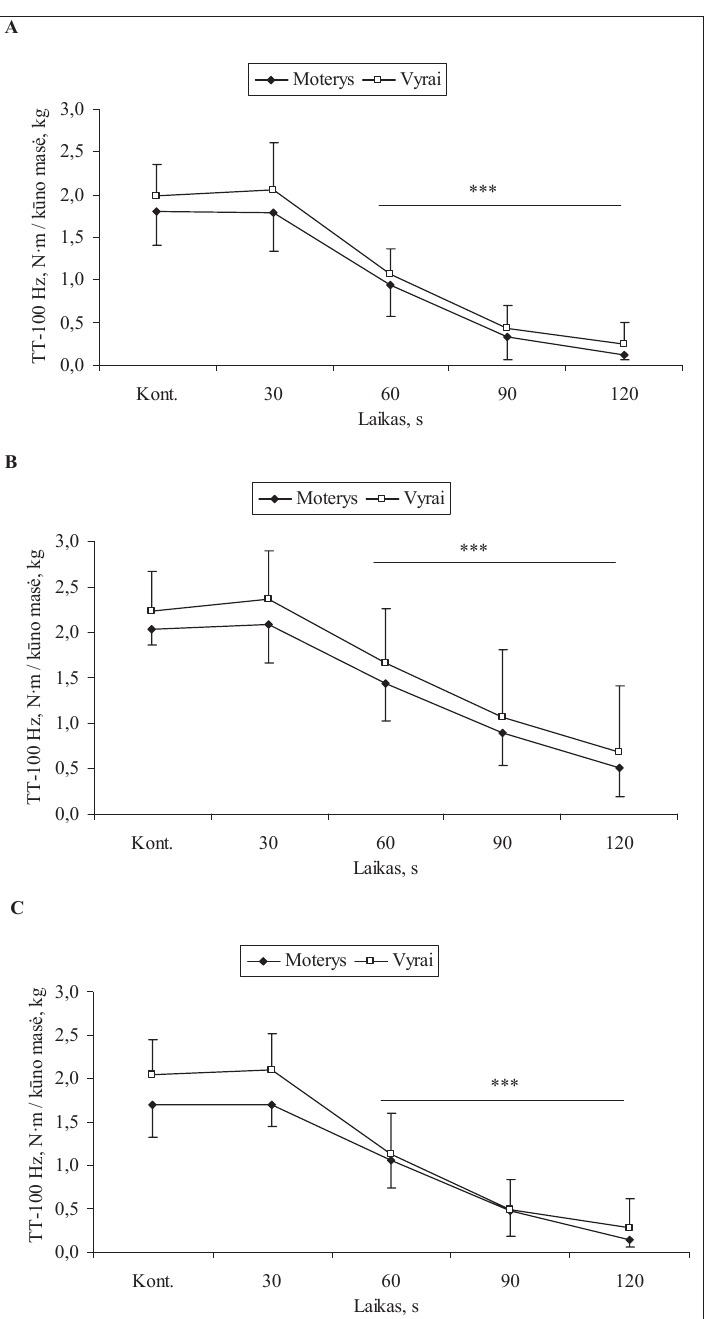
atgavo iš organizmo pašalint ą skyst į . Kr ū vio pa- baigoje nustatytas 15% didesnis CAR, t. y. atlie- kant MVJ-2 min buvo sumažintas centrinis nuo- vargis. Galima manyti, kad tai iš dalies